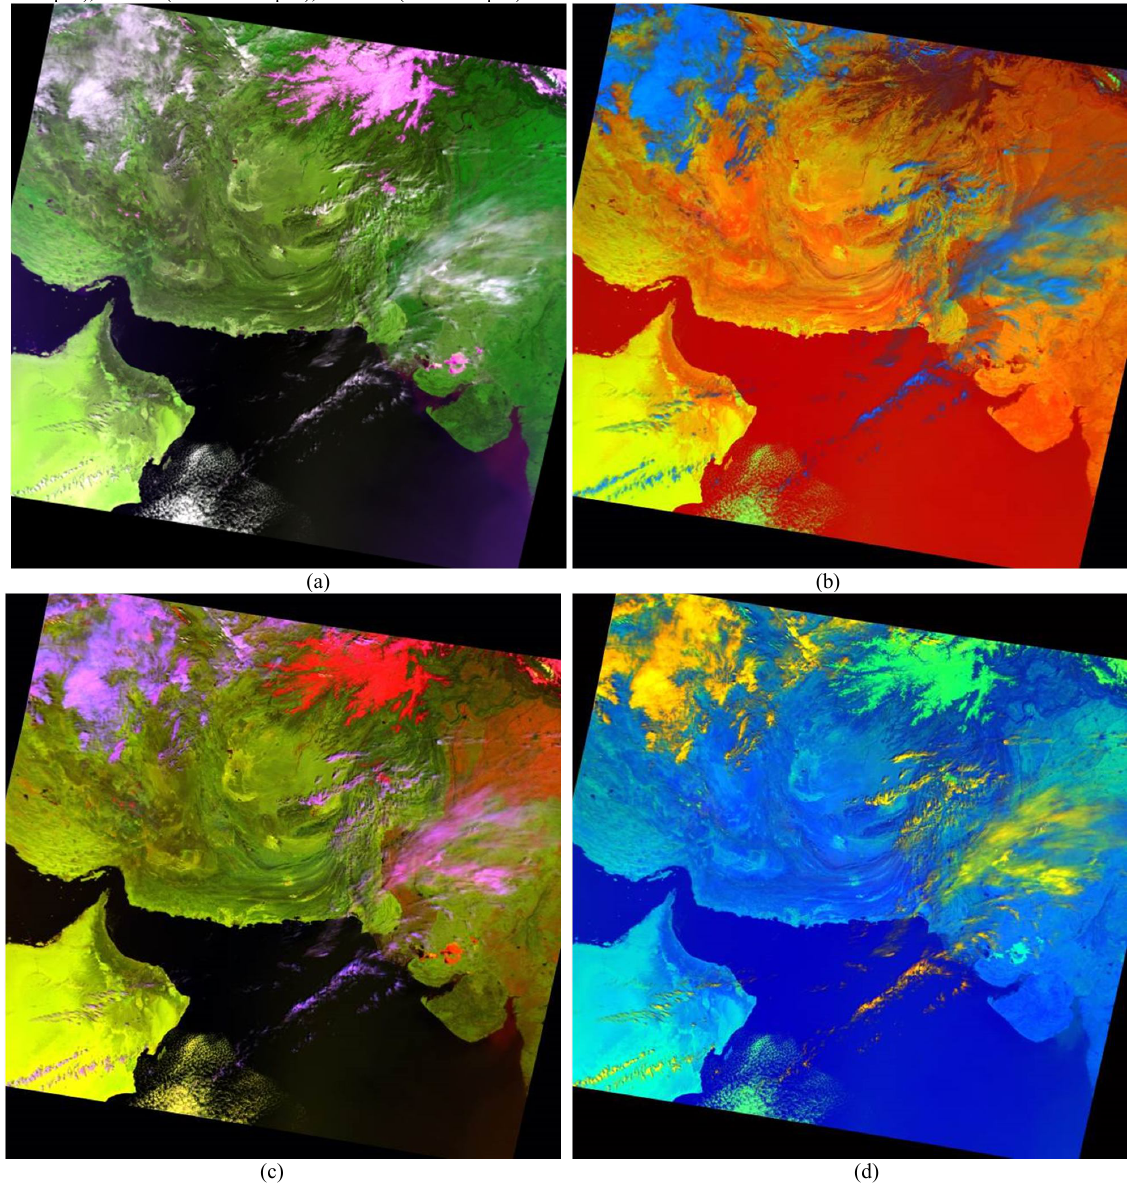
Figure 2. a) Image1(R: band 5, G: band 1, B: band 3) b) Image3(R: band 31, G: band 6, B: band 26) c) image2(R: band 26, G: band 2, B: band 31) d) image4(R: band 2, G: band 6, B: band